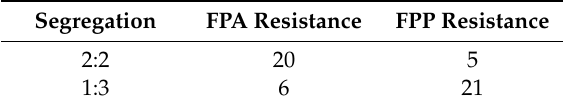
Table 5. Tetrad analysis of FPP and FPA